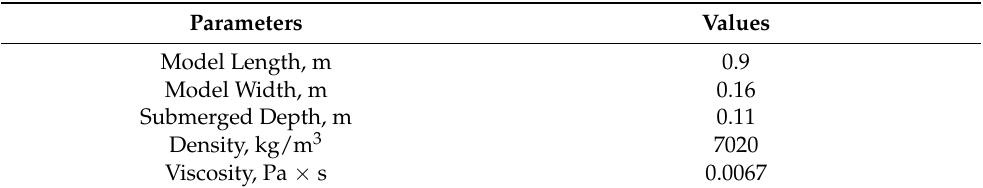
Table 6. Main parameters in the current calculation.